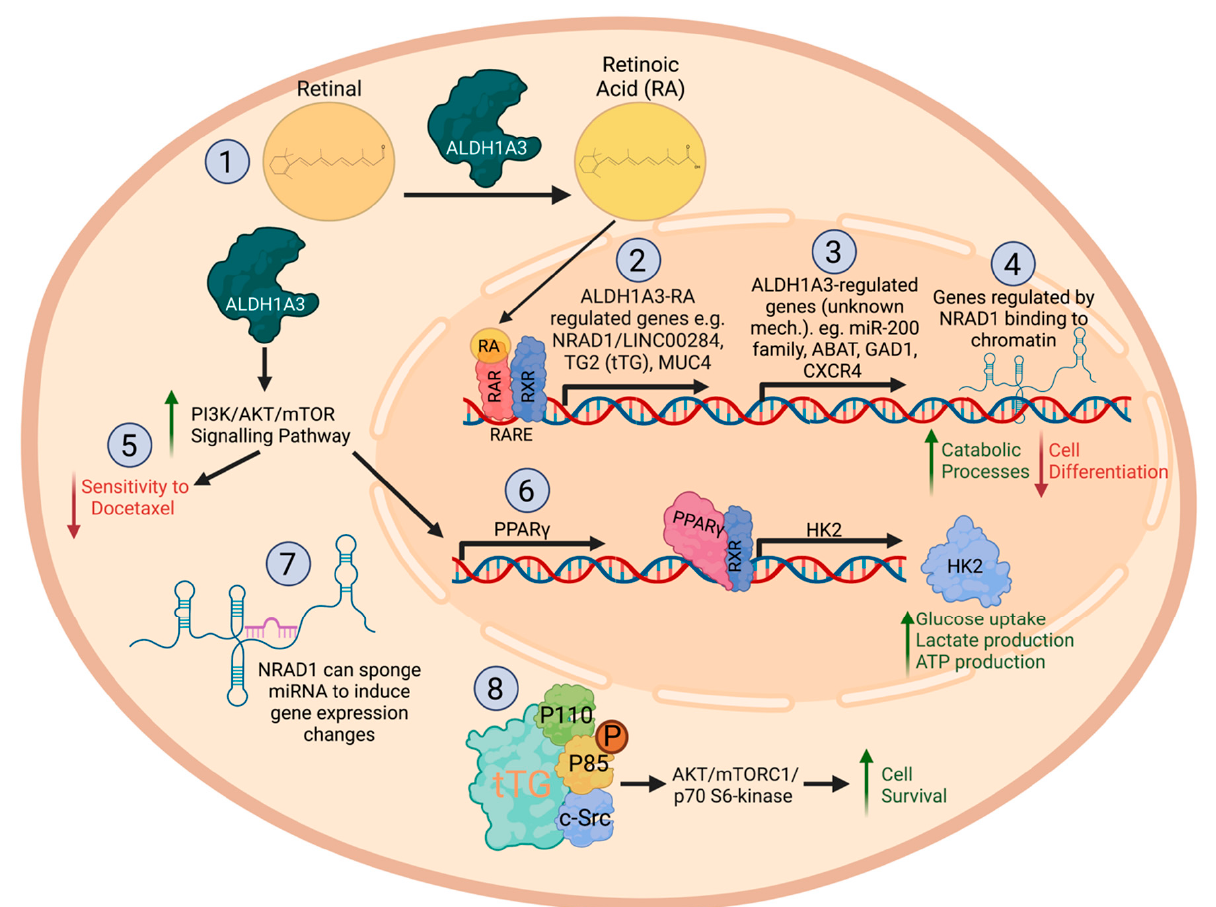
Figure 1. Cancer-promoting mechanisms of ALDH1A3. (1) ALDH1A3 can oxidize retinal to retinoic acid (RA) and [4] (2) RA induces gene expression changes by binding heterodimers of RAR and RXR, which are bound to RARE sequences in gene promoter regions [13]. RA-inducible genes include NRAD1 (LINC00284), TG2, MUC4. (3) ALDH1A3 also regulates the expression of many other genes through unknown mechanisms leading to cancer-promoting effects [40]. (4) ALDH1A3 regulates gene expression indirectly through NRAD1, an inducible gene by the ALDH1A3-RA pathway. NRAD1 binds chromatin leading to the regulation of genes enriched in biological processes that regulate catabolism and differentiation [77]. (5) Through ALDH1A3 the PI3K/AKT/mTOR signaling pathway becomes upregulated, which leads to a decrease in docetaxel sensitivity and [71] (6) PPAR γ levels [52]. PPAR γ forms a heterodimer with RXR and increases HK expression. HK increases glucose uptake, lactate production, and ATP production. (7) ALDH1A3-regulated NRAD1 can sponge miRNAs and therefore lead to gene expression changes [77]. (8) Through the ALDH1A3-RA pathway, tTG (encoded by TG2) binds to p110, p85, and c-Src to induce the AKT/mTORC1/p70 S6-kinase pathway and increases cell survival [78]. This figure was created with BioRender.com.